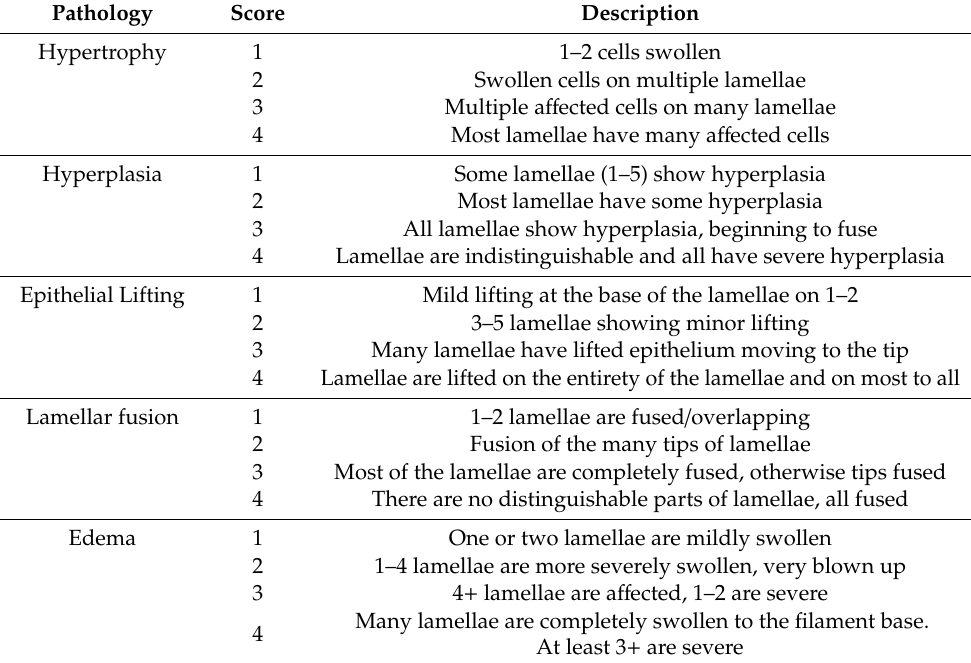
Figure A1. The respirometry set up in the field. River water was pumped directly into a reservoir where an “open” loop pump moved water through the chambers with oxygenated water for acclimation. During measurement, the “open” pump was closed off and the “closed” pump continued to circulate water through the device while the fish’s respiration was recorded by the oxygen probe and sent to the data logger and computer. Table A1. Gill pathology scoring descriptions. The description of the five common pathologies that were scored in each histological sample. An average score of all pathologies was taken from the sum of each sample at each site and compared to the reference site’s average to test for differences.